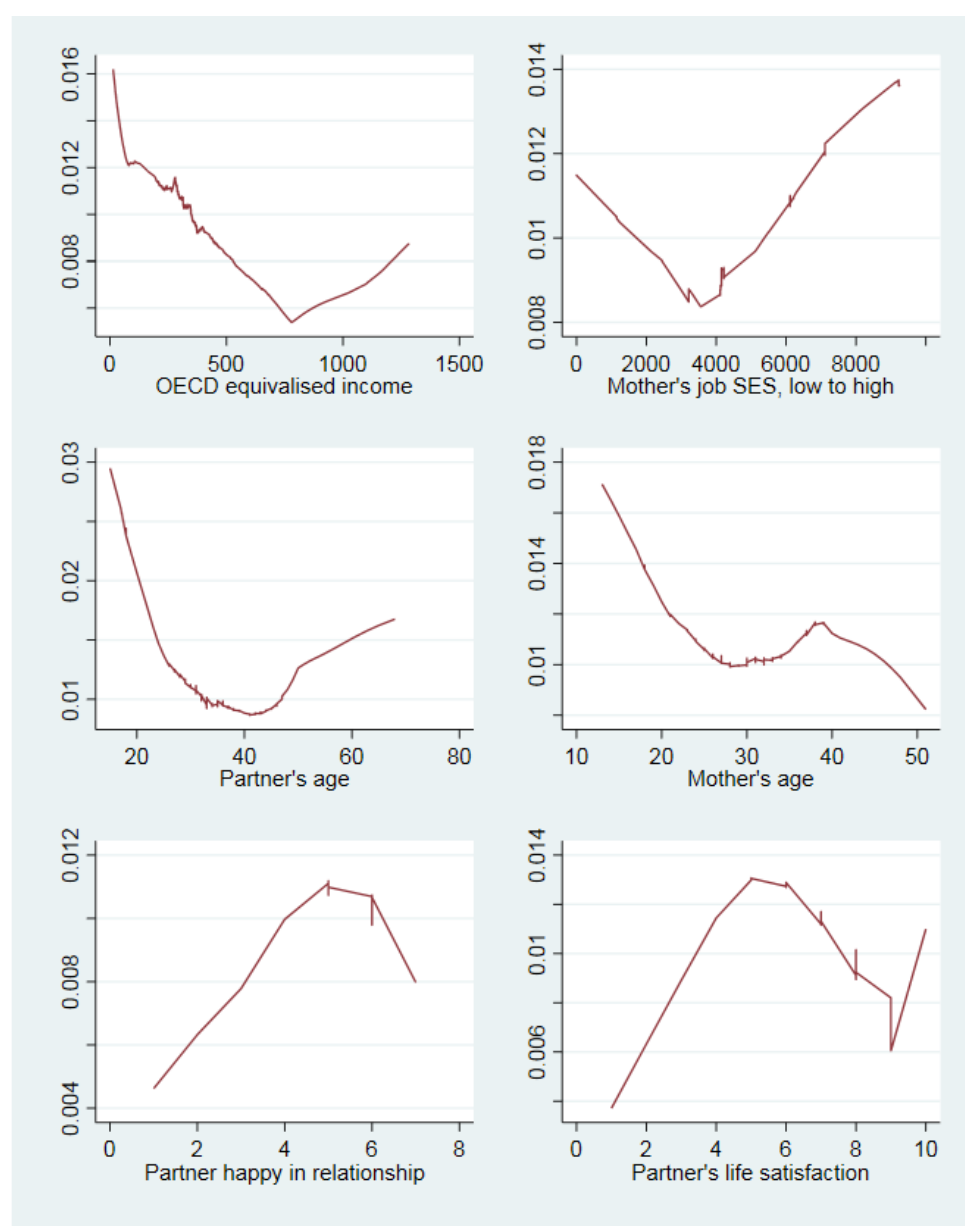
Figure 3. Scatter plots with lowess-smoothed trend lines showing relationships between the proportion of infants born before 32 weeks (y-axis), and the six predictors in the RF algorithms with the highest feature importance scores. SES by job (SOC2000) is coded from high to low, and relationship and life satisfaction are coded from low to high satisfaction. Data points are hidden to avoid visual confusion and show the trends clearly.